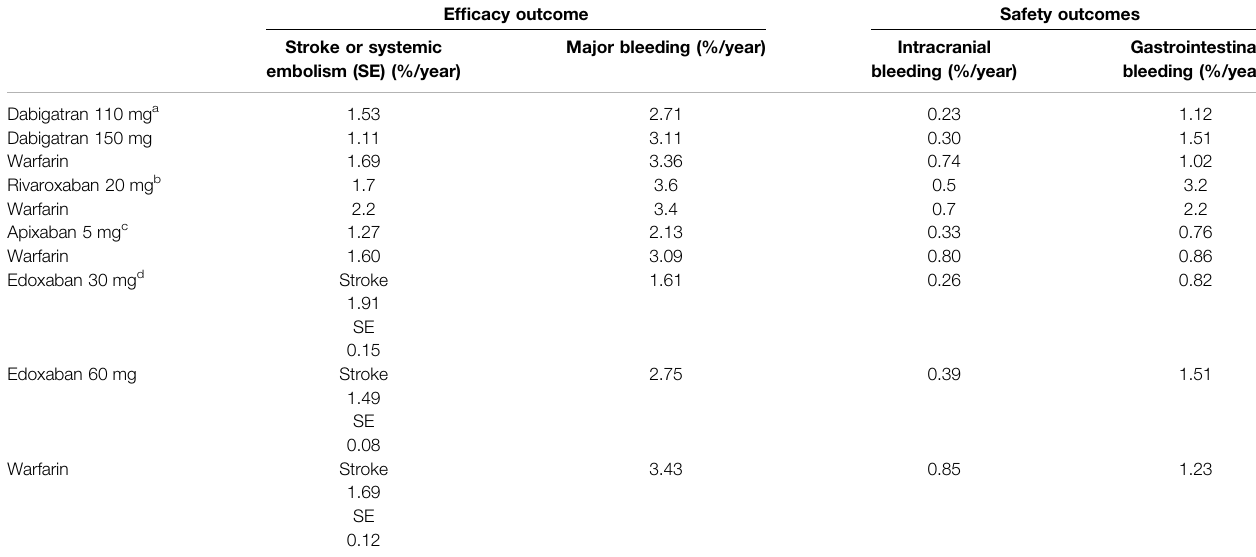
TABLE 2 | DOAC safety and ef fi cacy compared to Warfarin. Ef fi cacy outcome Safety outcomes Stroke or systemic embolism (SE)